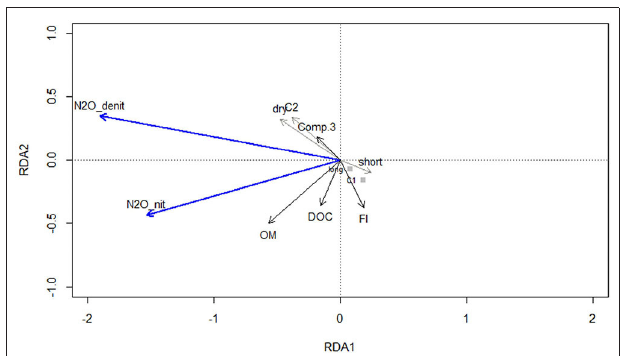
FIGURE 7 | RDA ordination triplot (type II scaling—correlation plot) of N 2 O fluxes derived from nitrification and denitrification. Response variables are ordinated as blue arrows, quantitative explanatory variables as black arrows and qualitative explanatory variables as gray arrows. Centroids for the long inundation treatment and cycle 1 are given as gray squares for